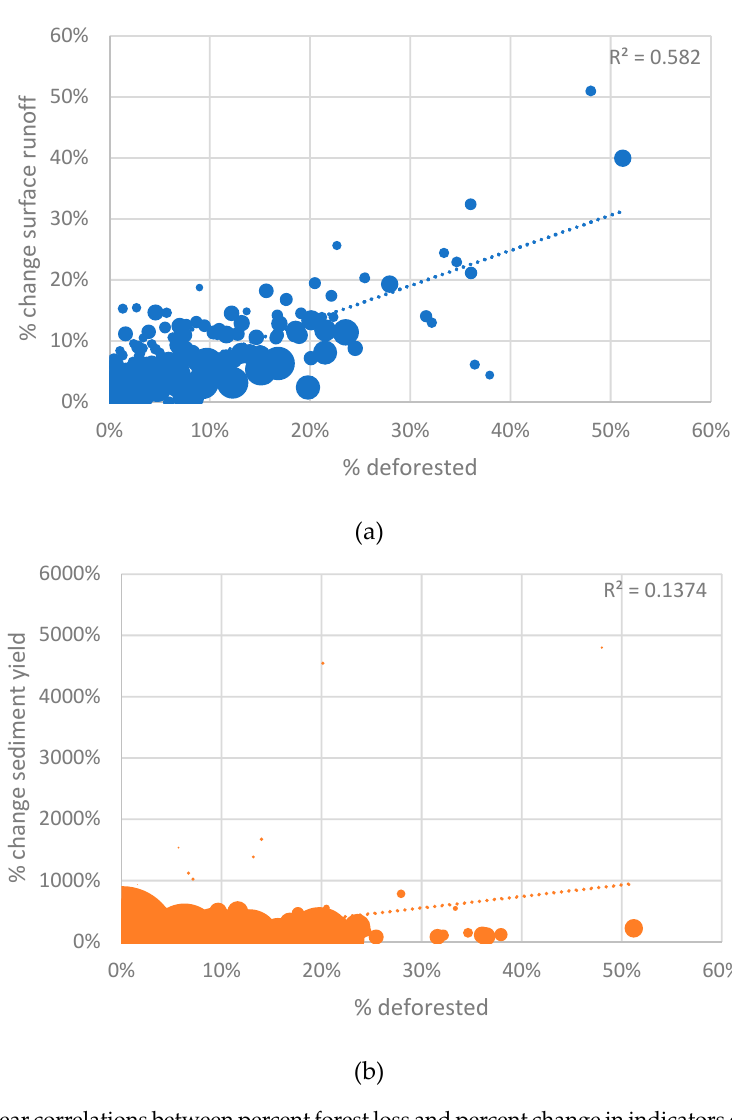
Figure 6. Linear correlations between percent forest loss and percent change in indicators of water-based ES. Each circle represents one sub-watershed within the Lower Mekong Basin, scaled by size of absolute value (mm for surface runoff ( a ) and t/ha for sediment yield ( b )). Results from the multiple regression analysis showed that for surface runoff, the highest adjusted R 2 achieved was 0.79 by adding three variables: percent change in runoff curve number, rainfall and slope (Table 3). For sediment yield, the highest R 2 relationship observed was 0.16 using two variables: percent change in Manning’s “ n ” for overland flow and absolute sediment yield (t/ha) from 2001.